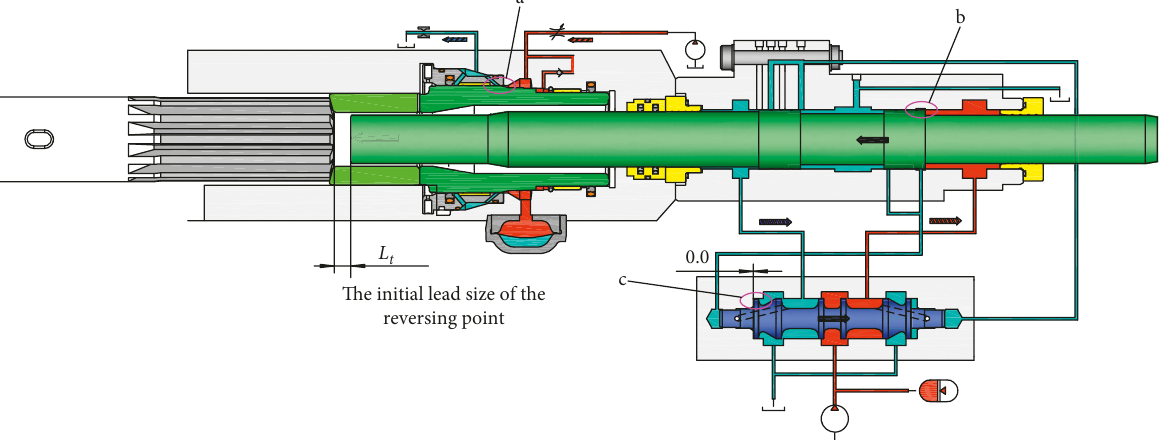
Figure 4: The position of the impact and damping piston when the reversing valve starts to Table 1: The parameter selection of the impact system. Initial parameters